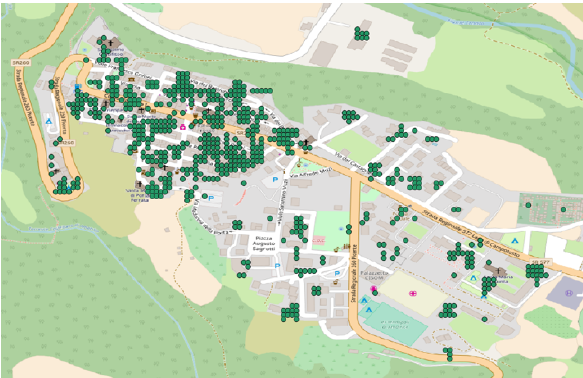
Figure 6. CCD results visualization for the descending-pass stack (area of Amatrice), basemap by OpenStreetMap